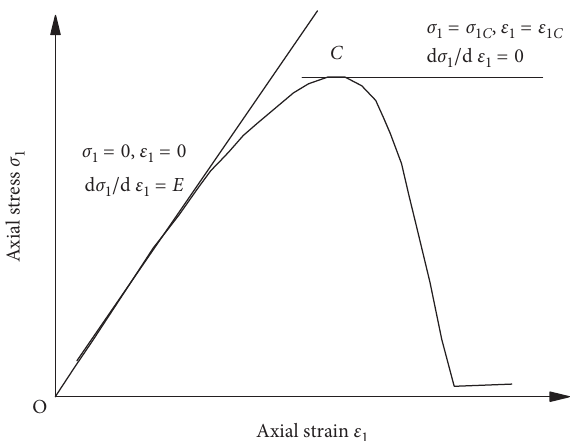
Figure 7: The geometric conditions of the deformation